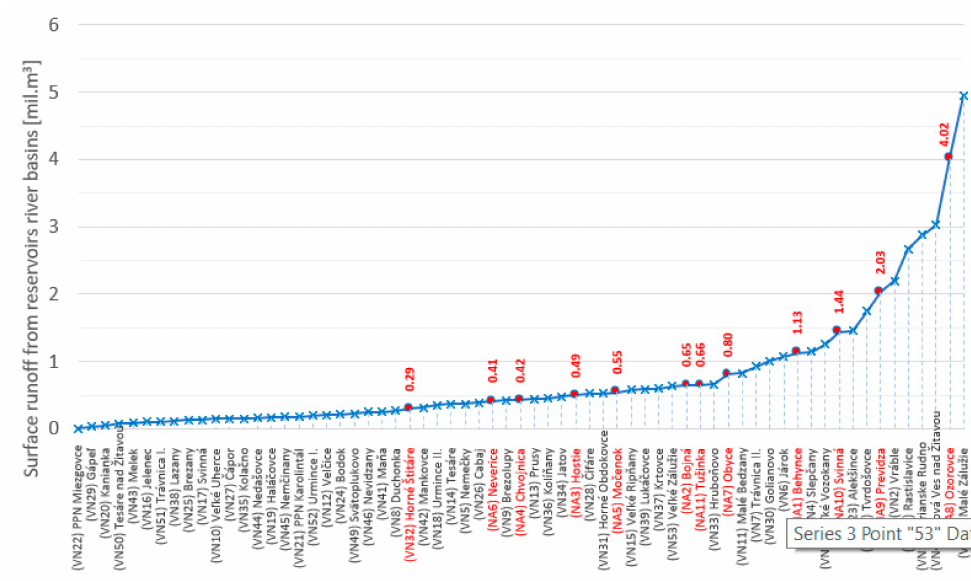
Figure 4. Volume of surface runo ff from reservoirs river